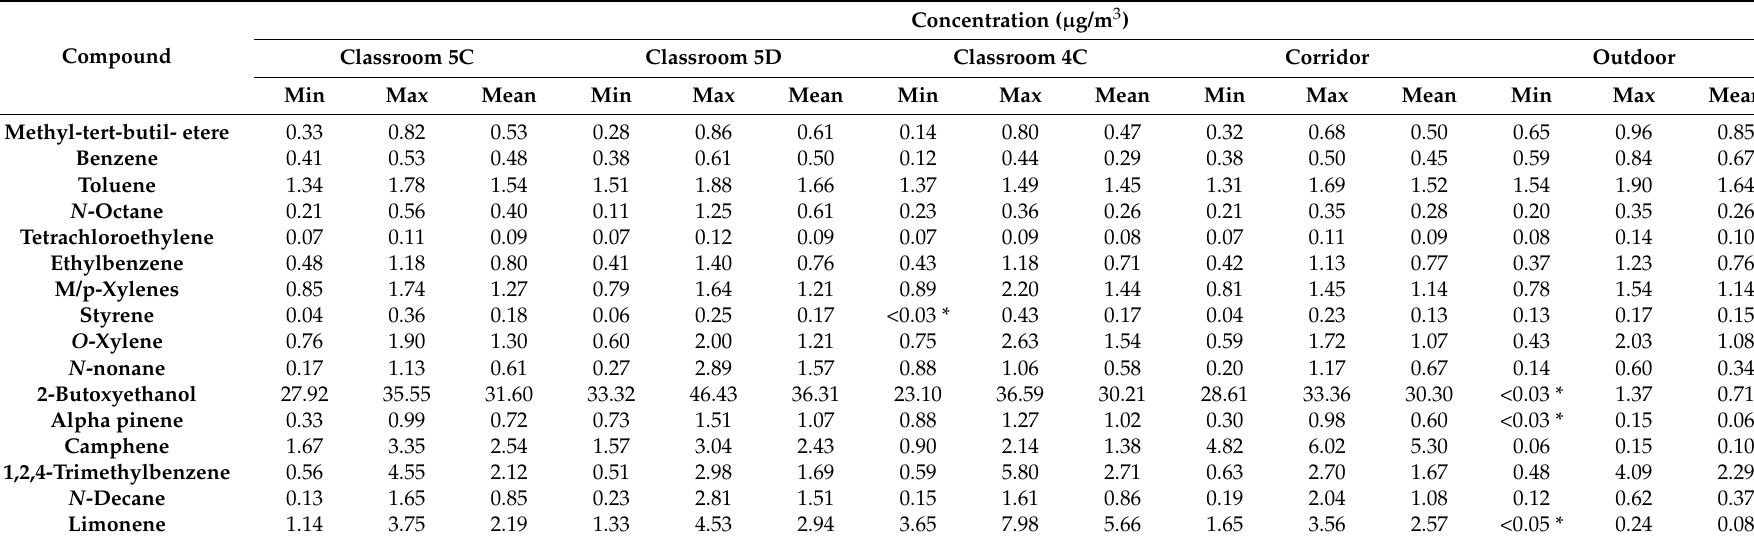
Table 1. Volatile Organic Compounds concentrations measured in indoor and outdoor monitoring sites (minimum, maximum and mean value).